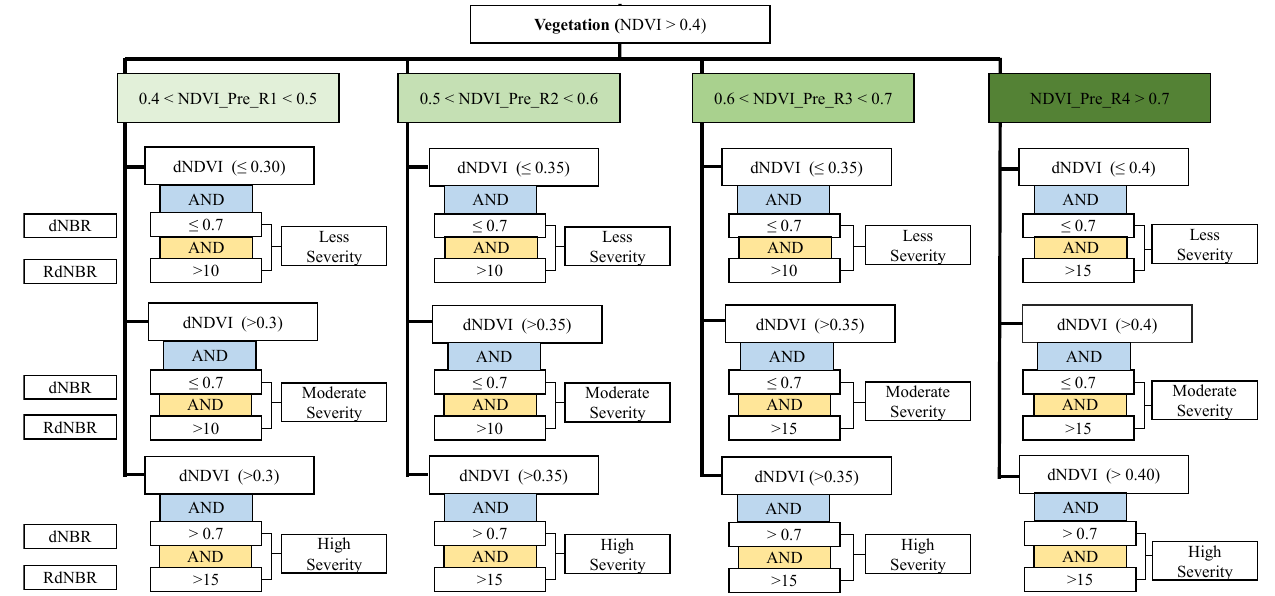
Figure 5. Decision Tree-based Multi-Threshold (DTMT) values for shifting cultivation area mapping; the pixel values for burned areas were negative in difference images (dNDVI, dNBR and RdNBR), which were converted into absolute values for convenience of representation .